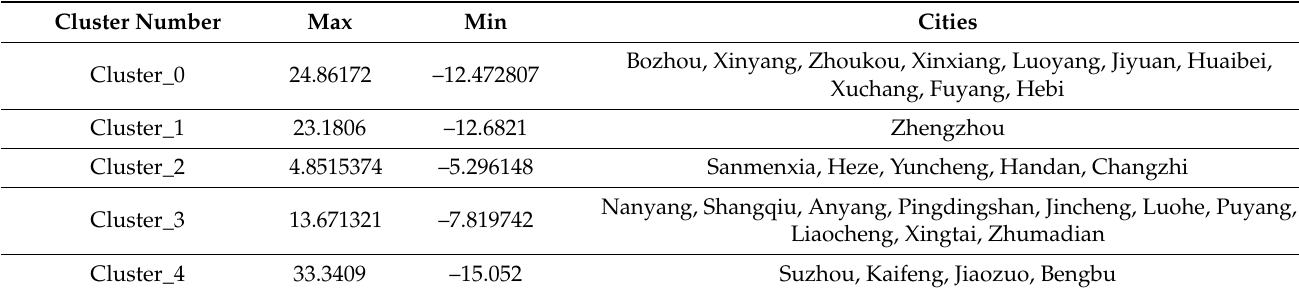
Table 3. Clustering results based on immigration.